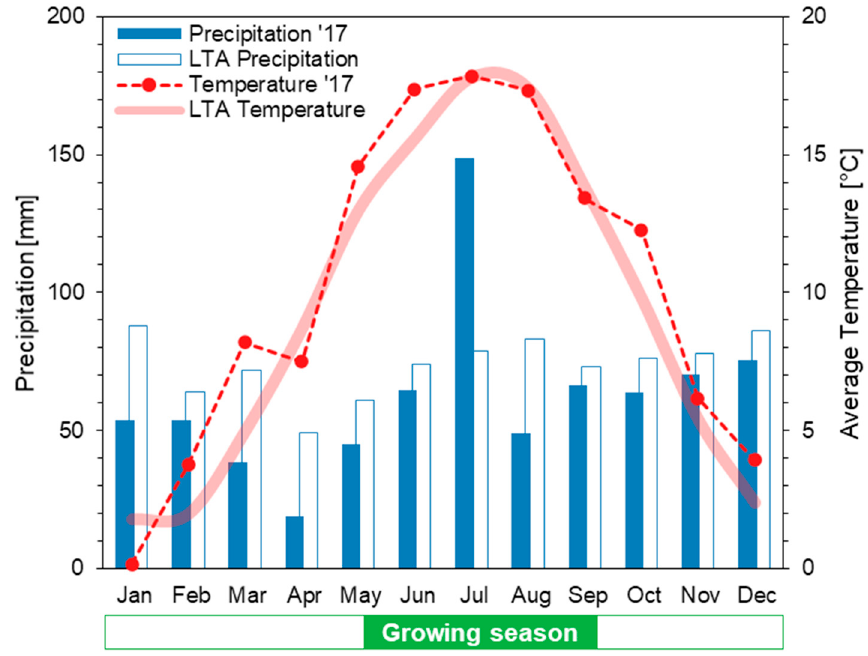
Figure 2. Climate diagram with long-term average values (LTA: 1981–2010) compared to the year 2017 for monthly precipitation and mean air temperatures. Data source: Reference [19].